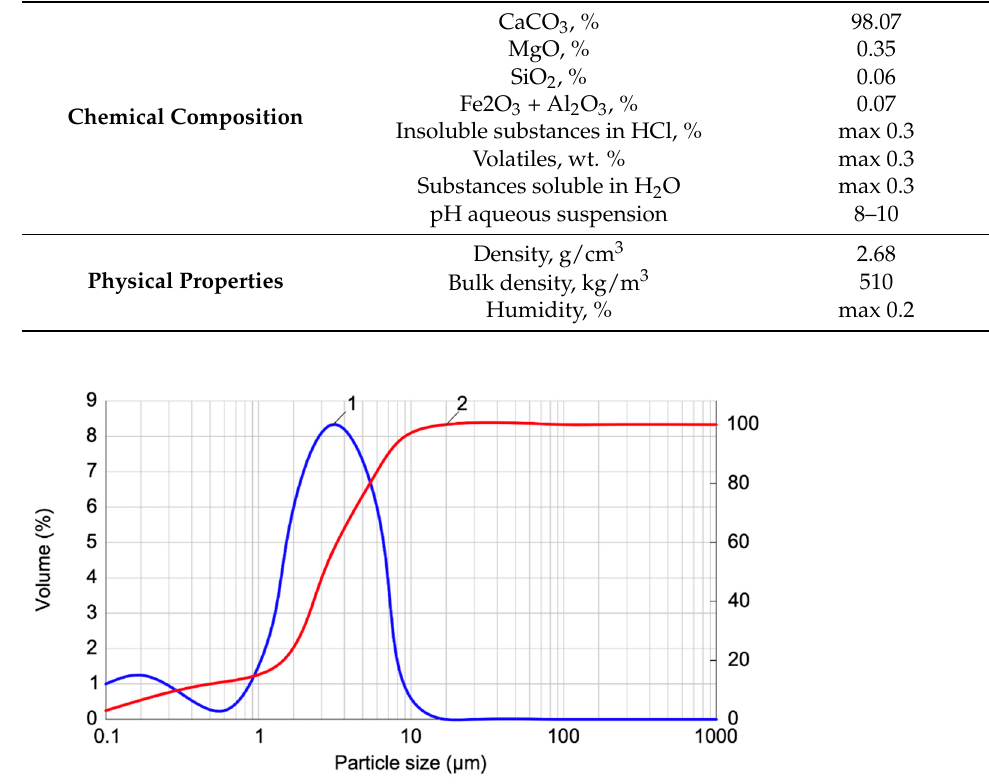
Table 6. Chemical composition and physical properties of micro calcite grade Km-2.